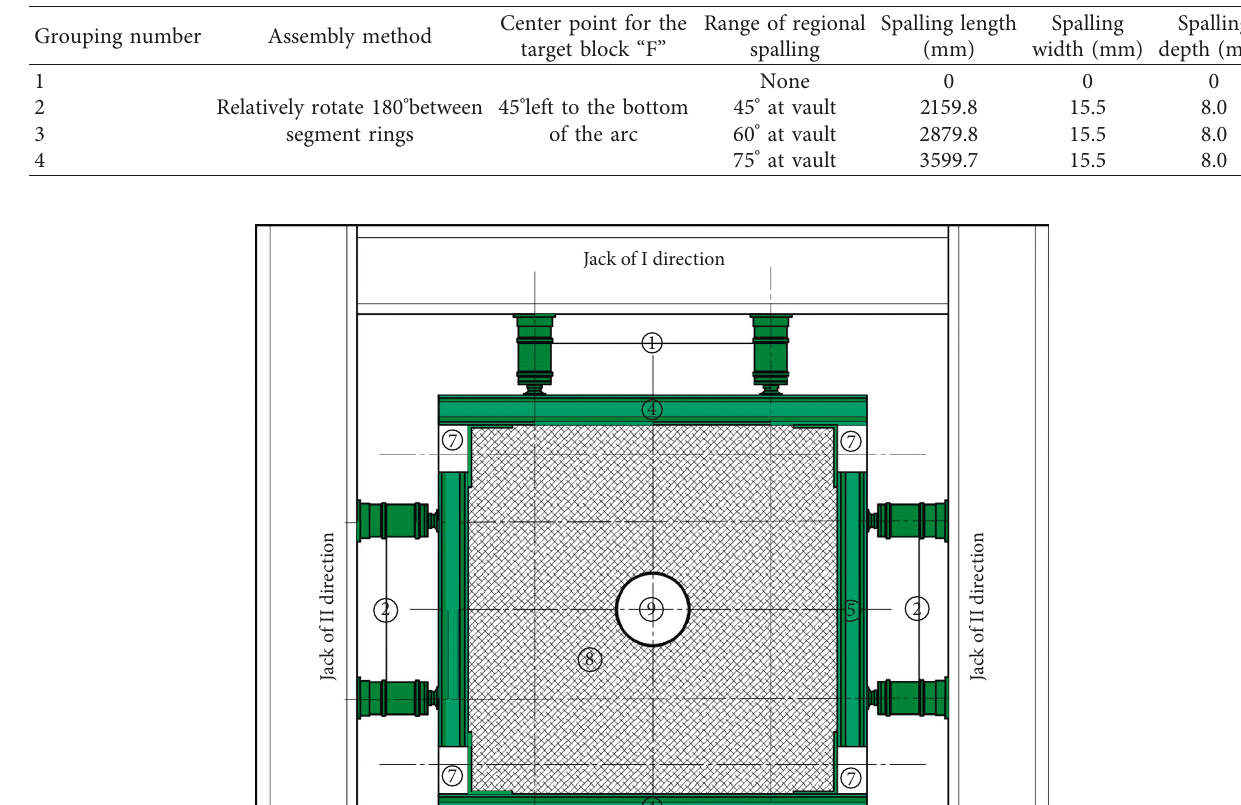
Table 6: Groups of test schemes.